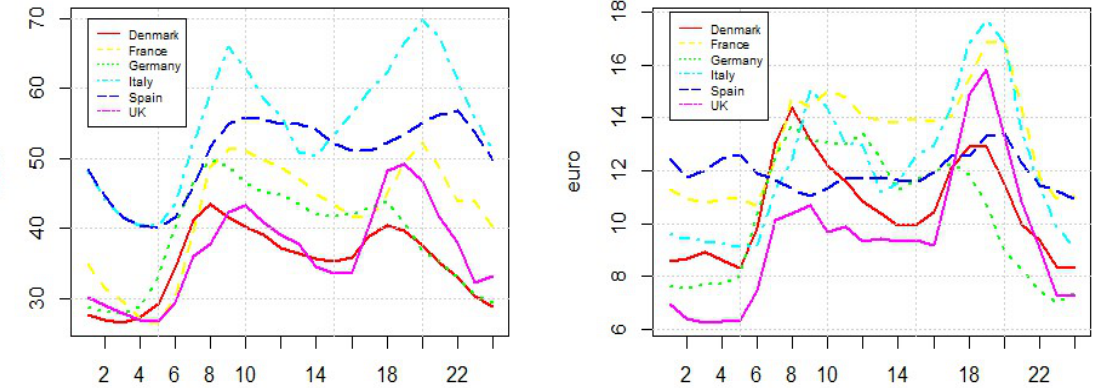
Figure 2. The median prices for each of the 24-hourly series for each country ( left plot ) and the robust estimate of the standard deviation ( right plot ).